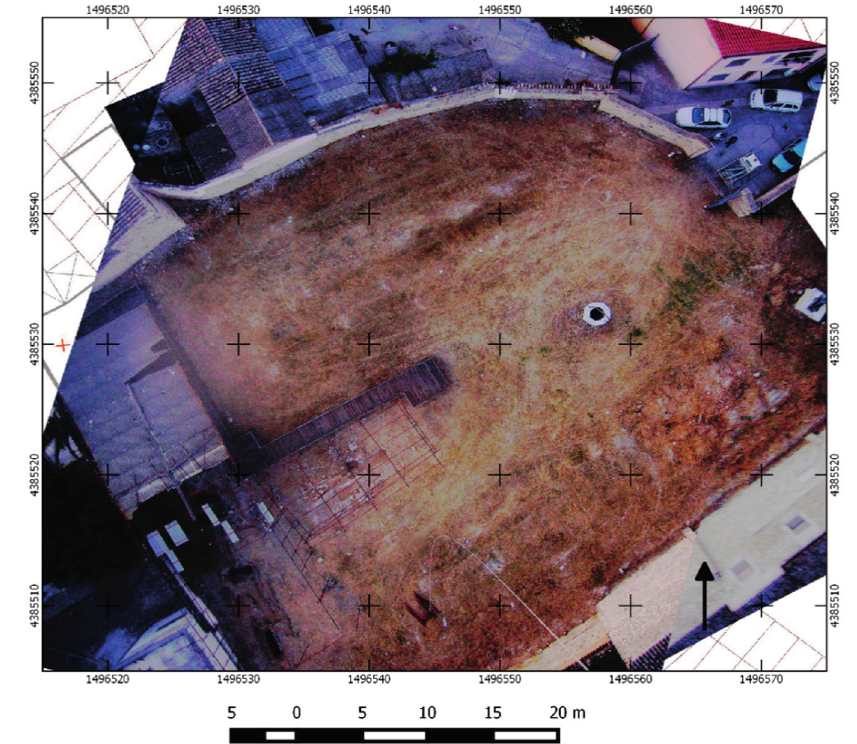
Figure 9. The aerial pictures of the test site acquired by the camera hanging from the